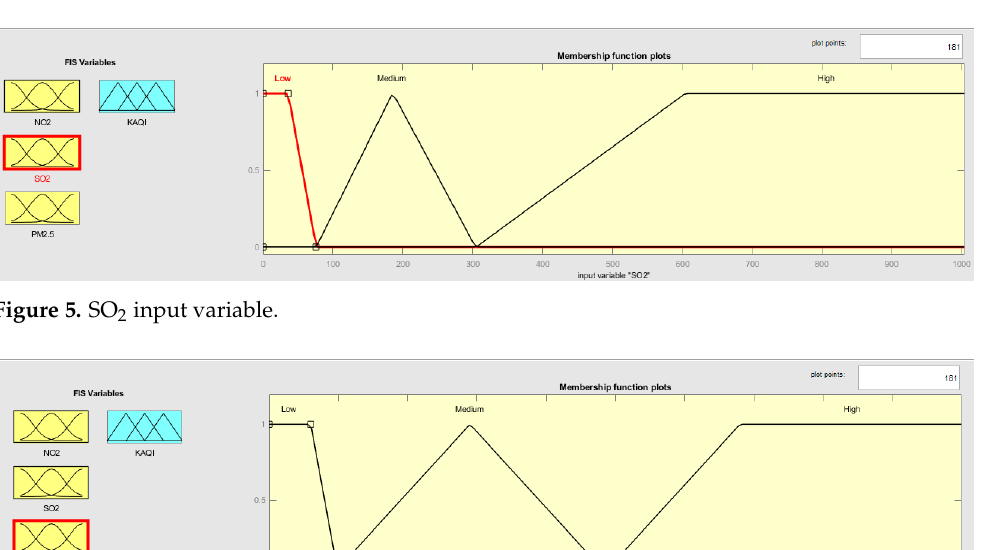
Figure 4. NO 2 input variable.